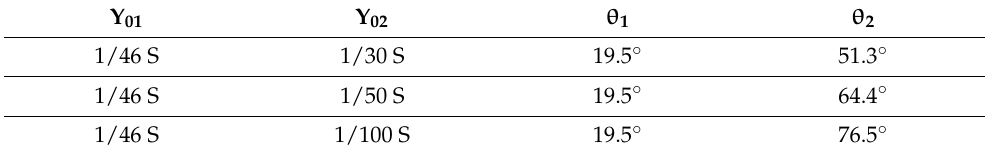
Table 3. θ 1 and θ 2 calculations using Equations (6)–(9) for CG2H40010 with f r = 3.5 GHz. Table 3. θ (cid:2869) and θ (cid:2870) calculations using Equations (6)–(9) for CG2H40010 with f (cid:2928) = 3.5 GHz .